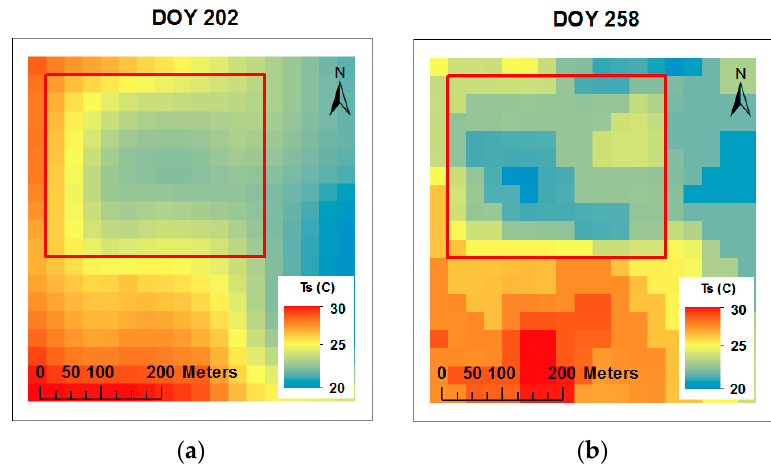
Figure 9. Maps of land surface temperature derived from the METRIC model, acquired using Landsat 7 (( b ) DOY 258) and Landsat 8 (( a ) DOY 202) with 60 m and 100 m spatial resolution, respectively, throughout the 2016 corn growing season. The red rectangle indicates the area of interest within corn field.